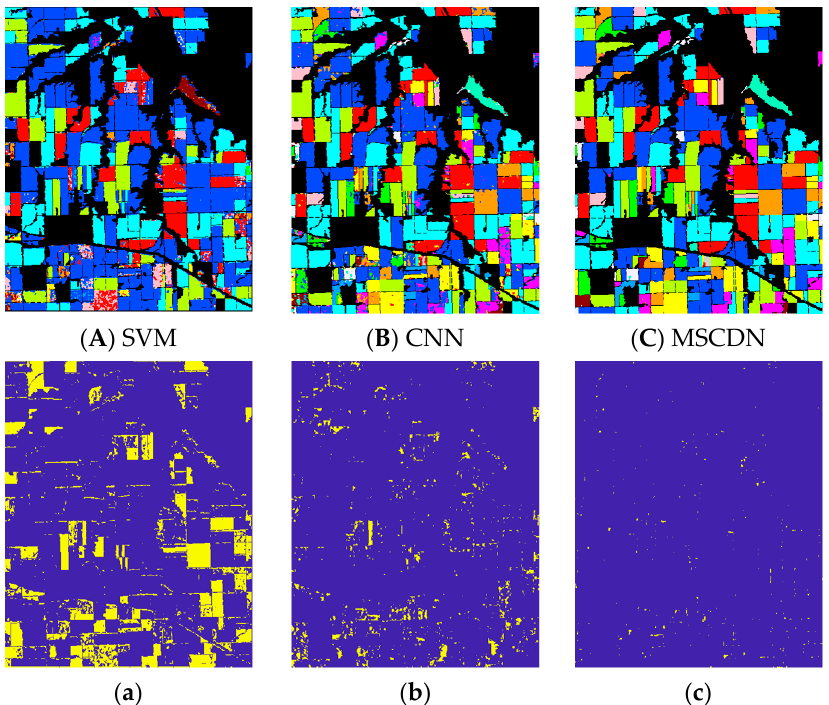
Figure 8. Classification results for different classifiers ( A ) SVM, ( B ) CNN, ( C ) MSCDN; ( a – c ) are the error maps of ( A – C ). Table 5. The recall rates and OA of crop classification of different classifier after NC-SAE dimensional reduction. Method Recall Rates for 14 Types of Crops and OA